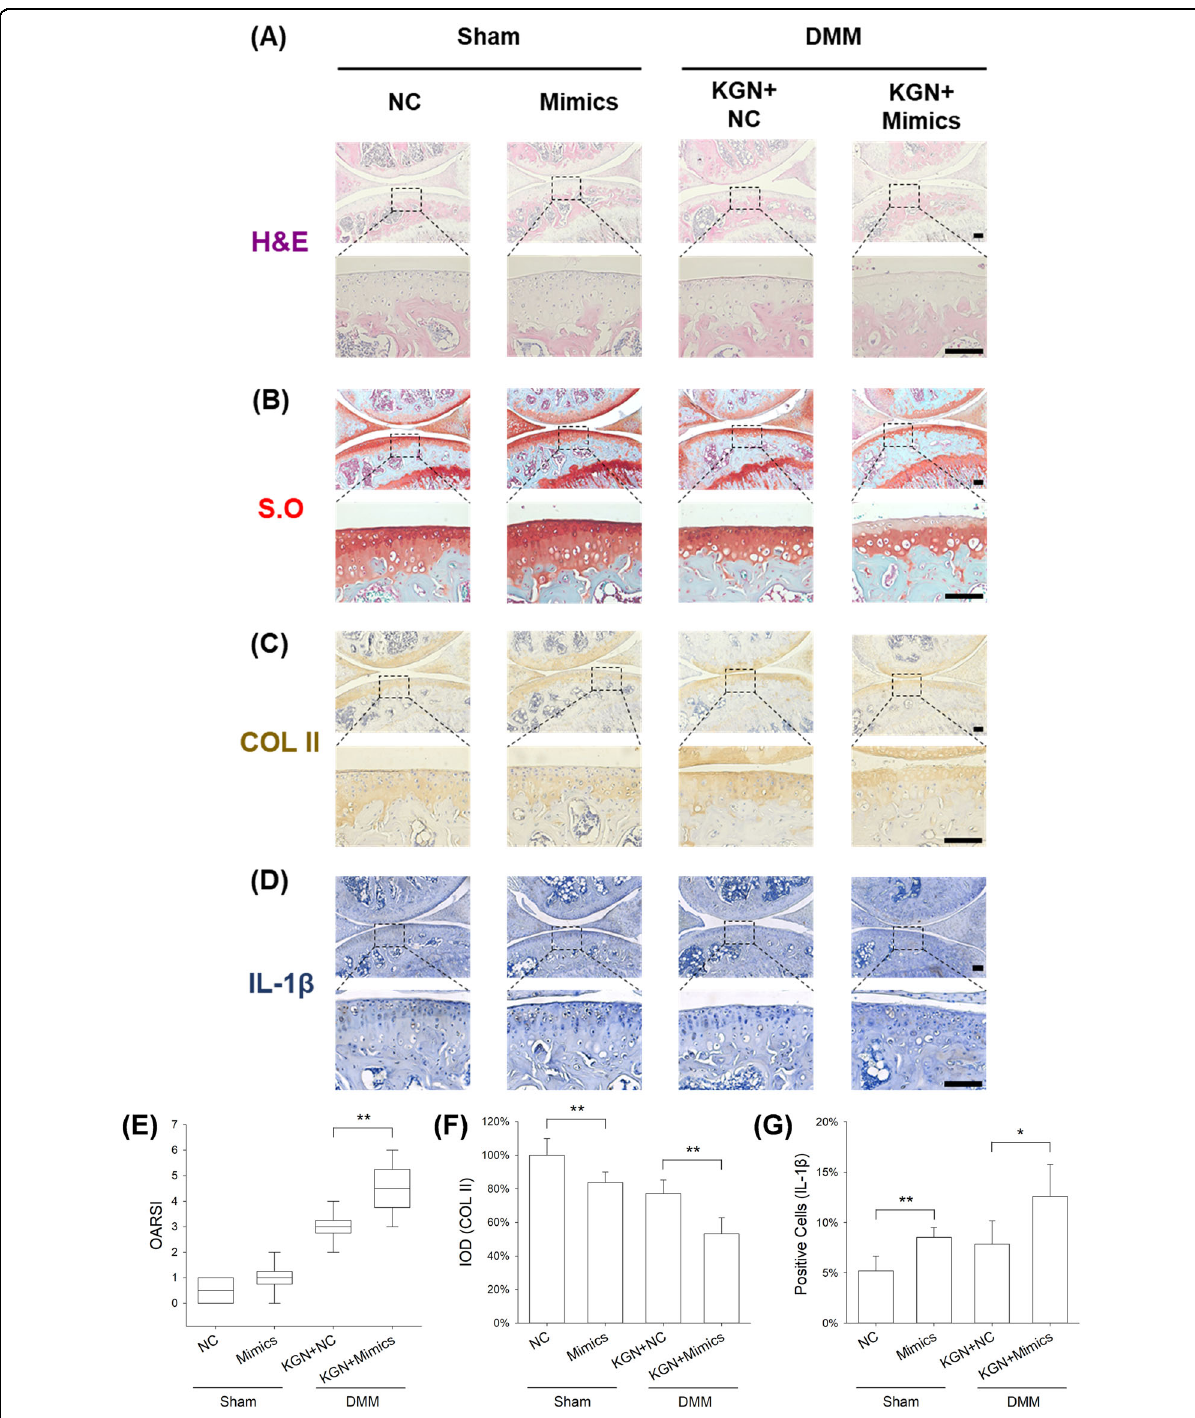
Fig. 7 Effect of up-regulated expression of miR-146a on KGN protective function against cartilage degeneration. A – D Representative histological images of medial femoral condyle and tibial plateau of OA mice following immunohistochemical staining. Sagittal sections of cartilage following A hematoxylin and eosin (H&E) staining, B Safranin O (S.O.)/Fast Green staining, C immunohistochemistry for COL II (IHC), and D immunohistochemistry for IL-1 β (IHC). (Scale bar = 100 μ m). E OARSI scores based on Safranin O/Fast Green staining. F Integrated optimal density (IOD) of COL II in articular cartilage. G Percentage of IL-1 β positive cells in articular cartilage. In each section, the quantitative analyses were performed at three random regions, with the average used as the fi nal value. Values represent mean ± S.E.M of six replicas. (* p < 0.05 and ** p < 0.01; between the indicated groups and # p < 0.05 or ## p < 0 . 01 versus the CTRL group).